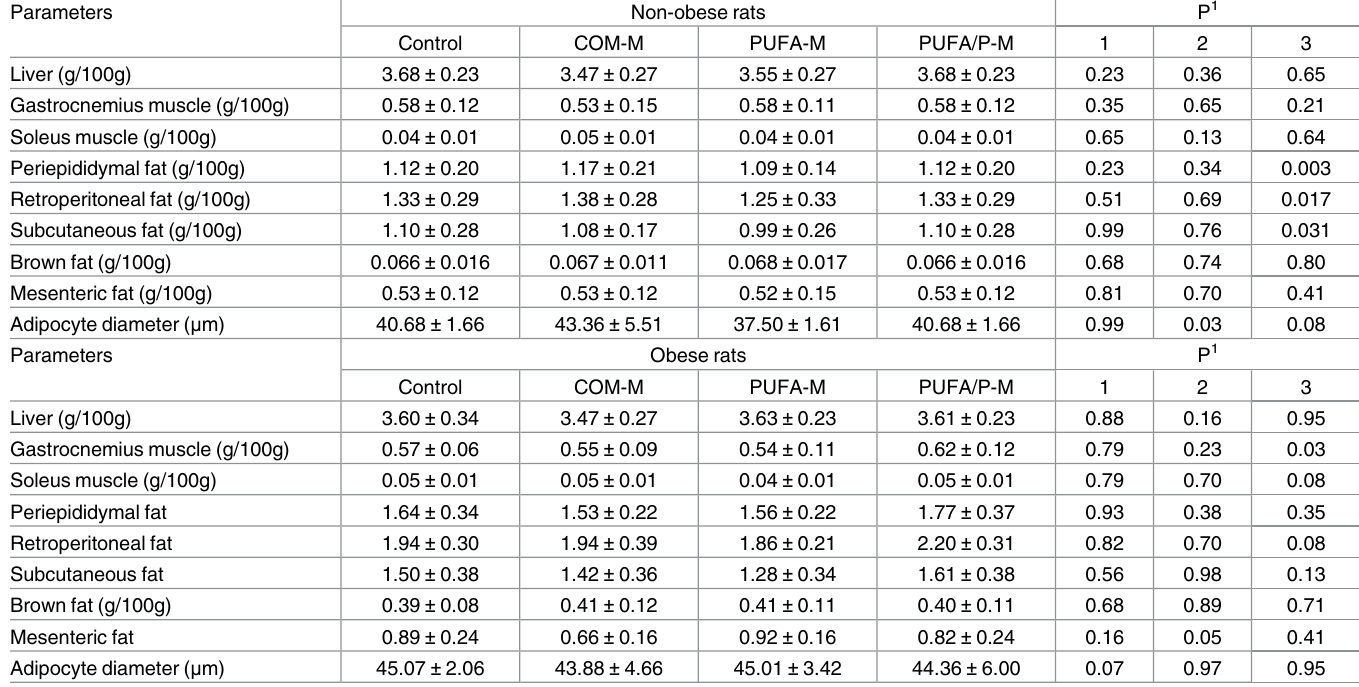
Data are mean ± standard deviation.